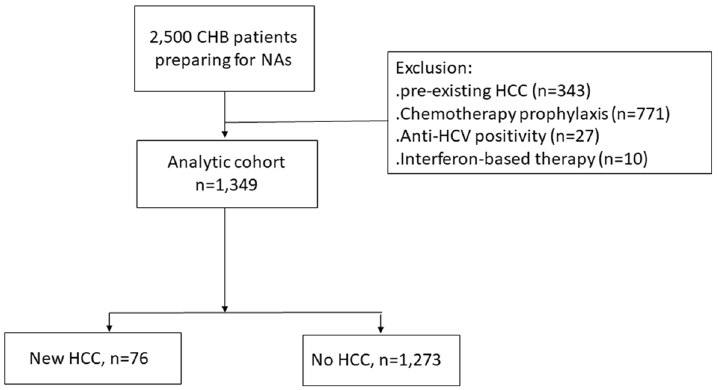
Figure 1. The flowchart of patient enrolment. CHB: chronic hepatitis B; NAs: nucleoside/nucleotide analogue; HCC: hepatocellular carcinoma; ALT: alanine aminotransferase; HCV: hepatitis C.